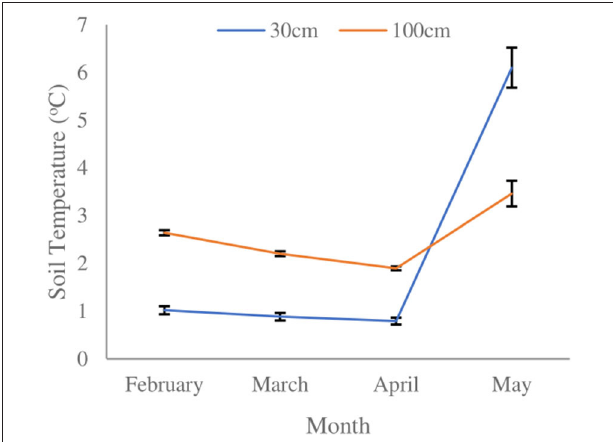
FIGURE 3 | Comparing total growth of H. fasciculare between 30 and 100cm soil depths during winter and early spring seasons from February 1 to May 13, 2018. Black bars indicate ±